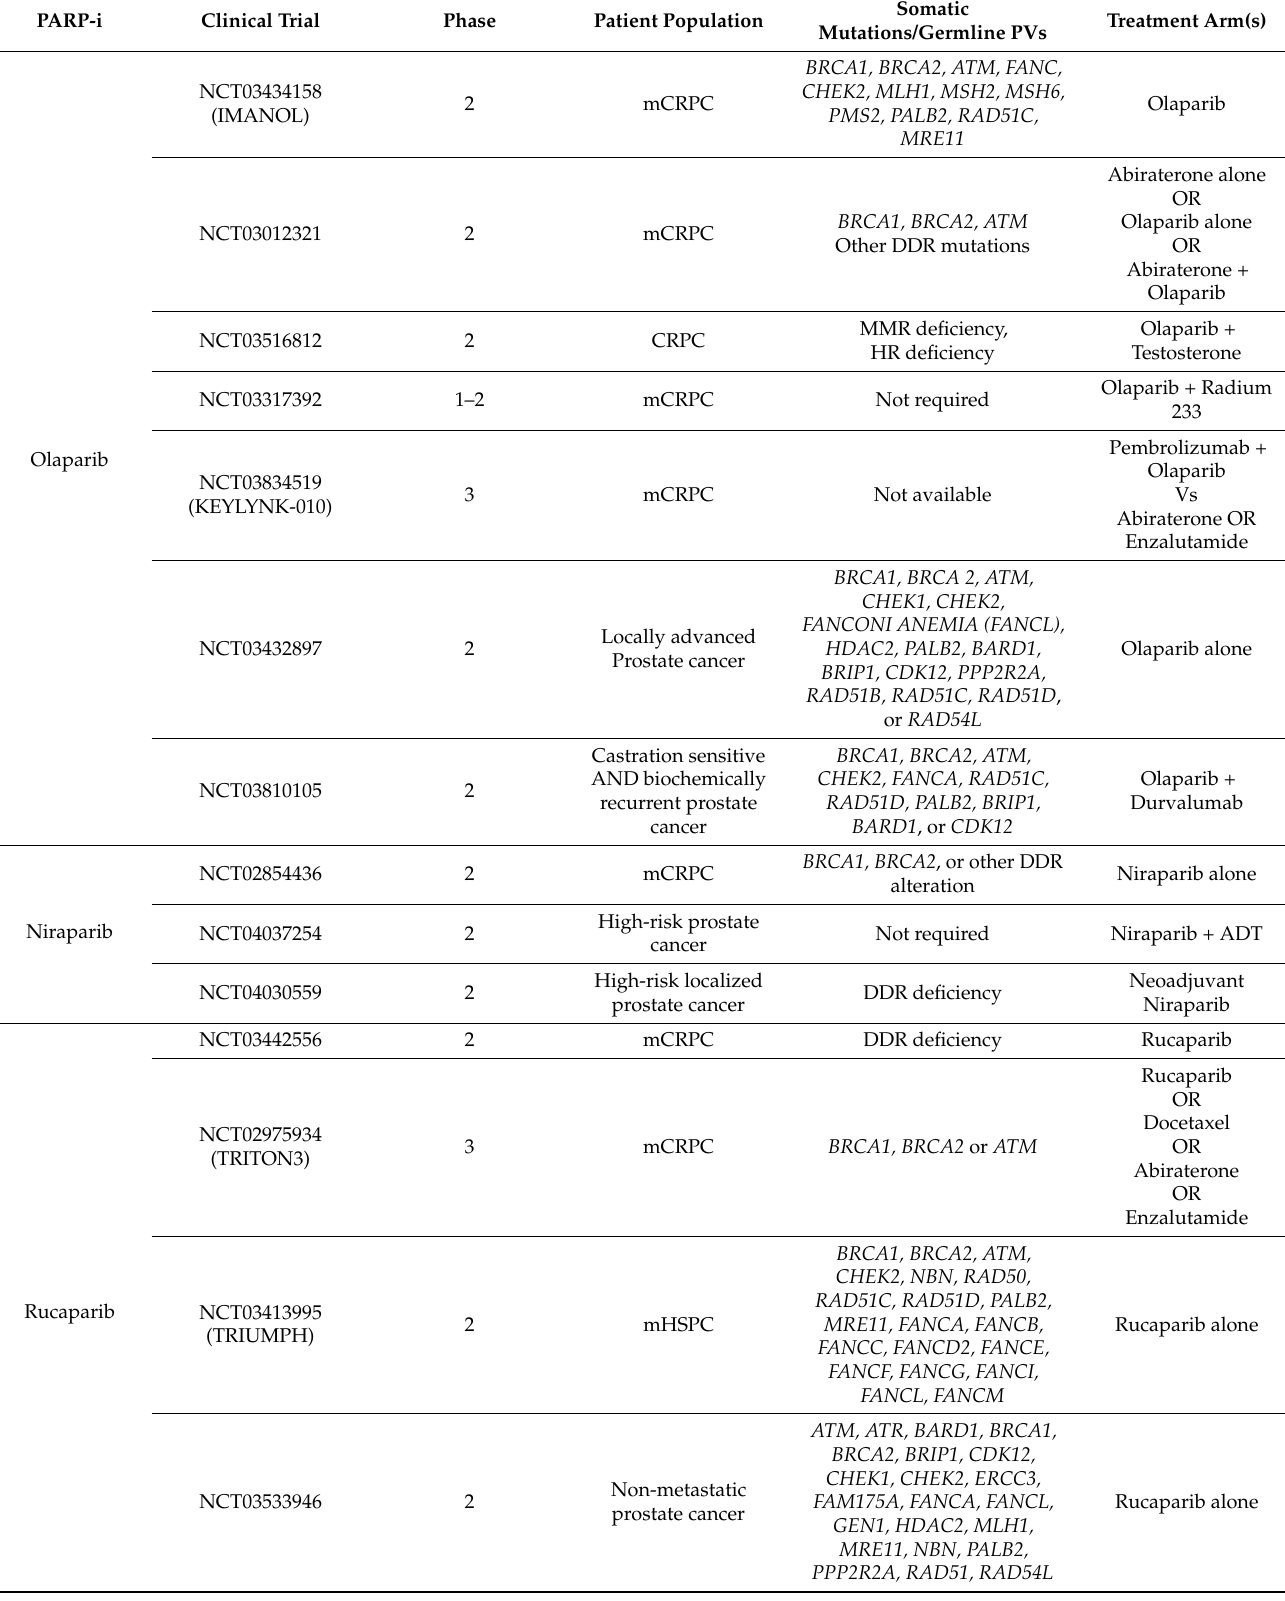
Table 4. Active clinical trials on PARP-i in prostate